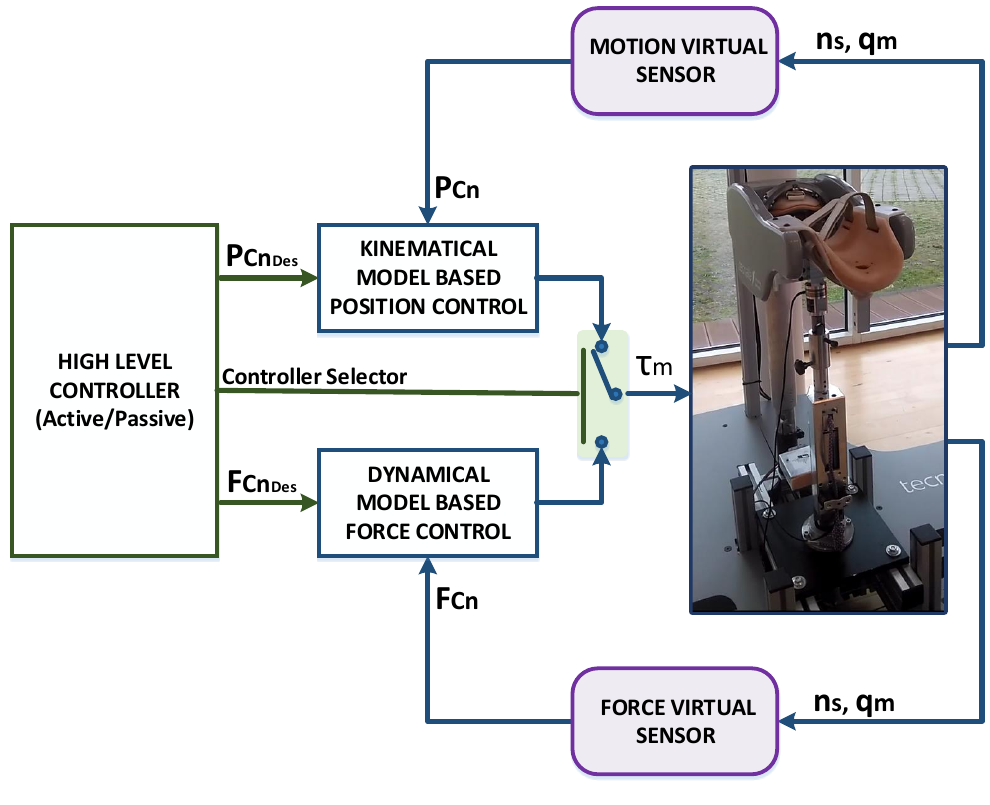
Figure 5. Advanced Controller for the UHP rehabilitation robot with Motion and Force Virtual Sensors.